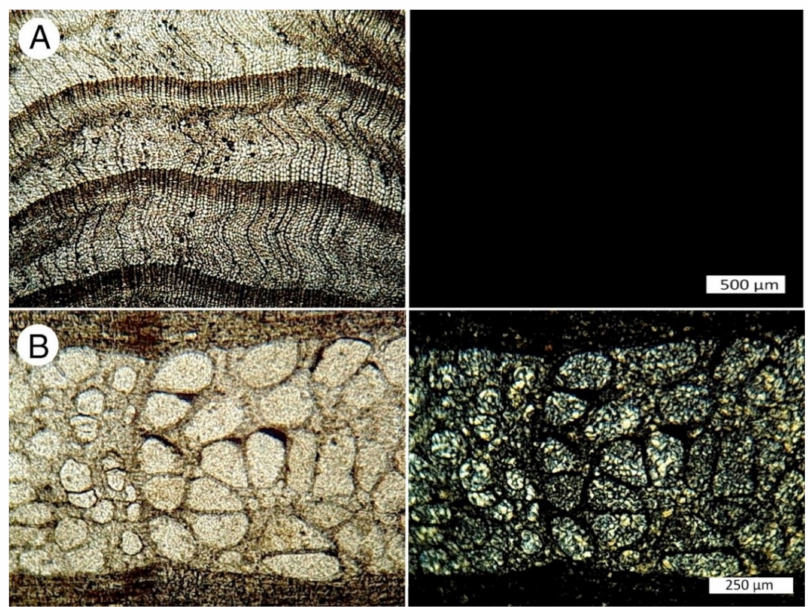
Figure 23. Petrographic microscope views of woods mineralized with opal-A and opal-CT. Ordinary transmitted light view on left, polarized light image on right. ( A ) Transverse view of Miocene wood from Georgia nation. The isotropic nature of the polarized view is evidence of amorphous opal-A. Note the pronounced difference of cell sizes that comprise the three pairs of annual growth rings. Specimen provided by Miriam Makazde. ( B ) Opalized Miocene wood from Badger Pocket, Yakima Firing Center, central Washington, USA. Polarized light view shows the low birefringence typical of opal-CT that fills cell lumen of cells within a single growth ring. Specimen provided by T.A. Dillhoff.